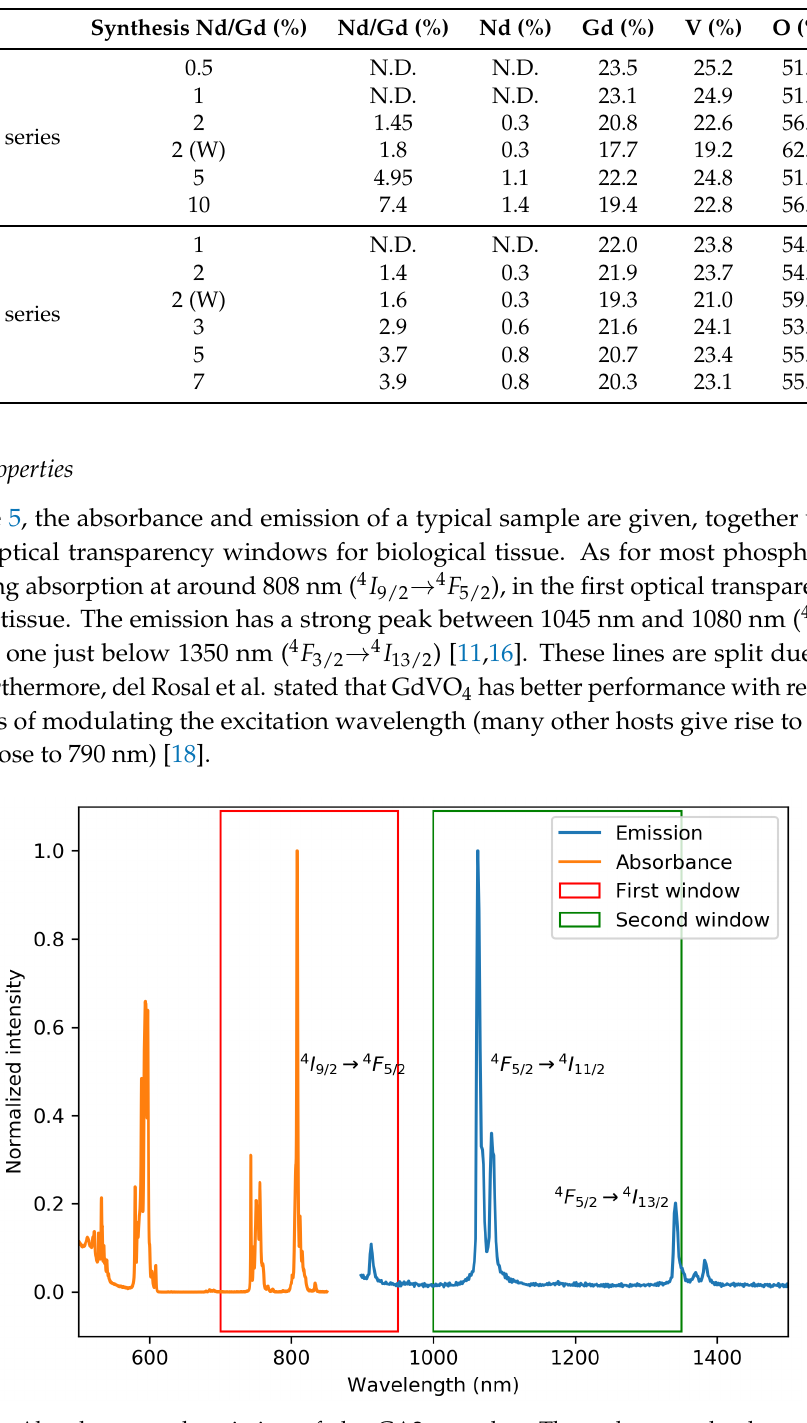
Figure 5. Absorbance and emission of the GA2 sample. The red rectangle shows the first optical window, and the green rectangle shows the second optical window of the biological tissue. The excitation source was a 500 mW 808 nm diode